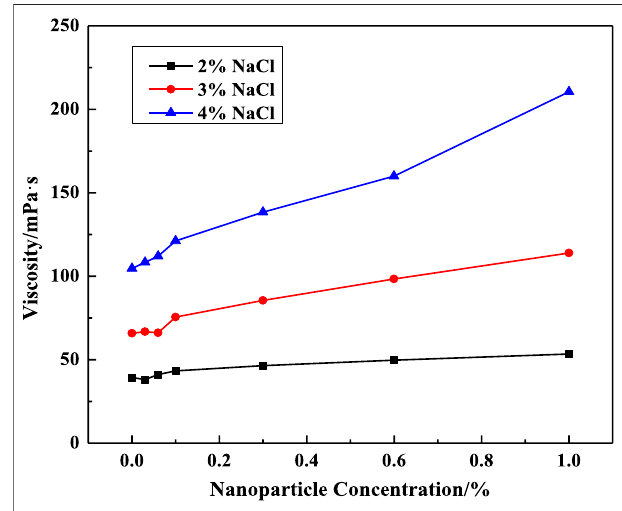
FIGURE 5 | Effect ofSiO 2 concentration on solution viscosity at different nanoparticle diameters ( w (LBA + SDS) (cid:2) 0.8%, LBA:SDS (cid:2) 3:1, T (cid:2) 50 ° C, w (NaCl) (cid:2) 3%, γ (cid:2) 7.34s − 1 ).